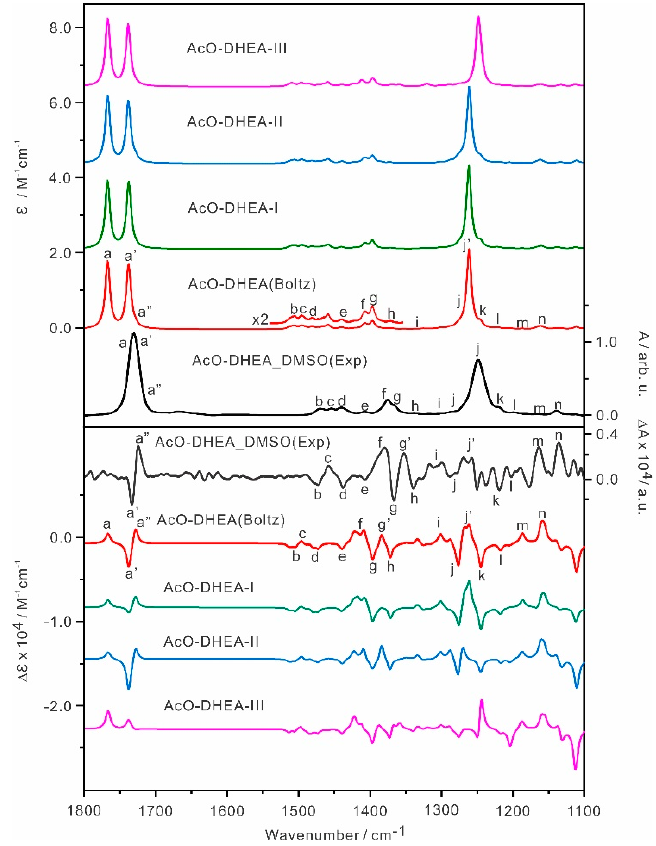
Figure 6. Simulated IR and VCD spectra of the three most stable AcO − DHEA conformers, AcO − DHEA − I to − III, and the related Boltzmann averaged IR and VCD spectra at the B3LYP − D3BJ/def2 − TZVPD/PCM(DMSO) level of theory at 298 K. The experimental units are on the right side. The main IR and VCD band features are labelled as ‘a’ to ‘n’ to aid the comparison.